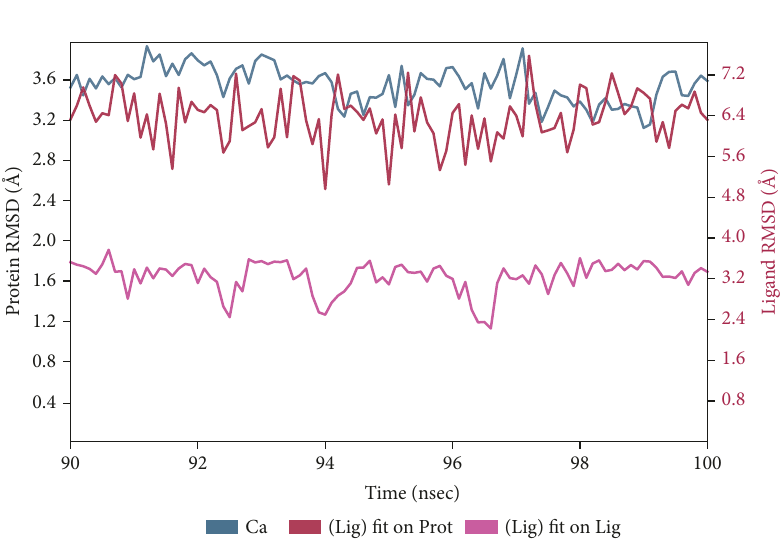
Figure 4: Plot of protein-ligand